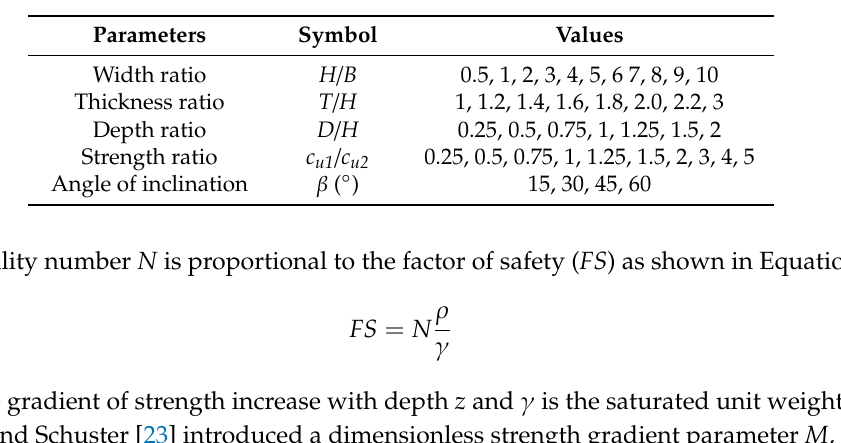
Table 1. The range of the parameters studied.